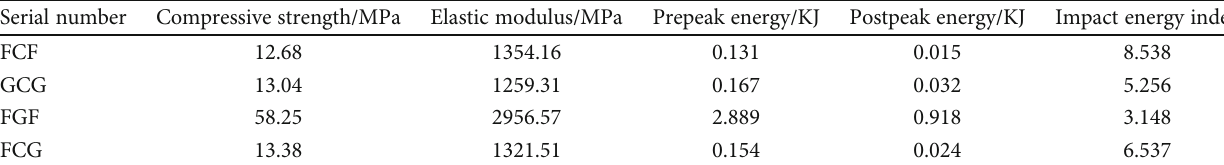
Table 3: The average data of each parameter of the combined